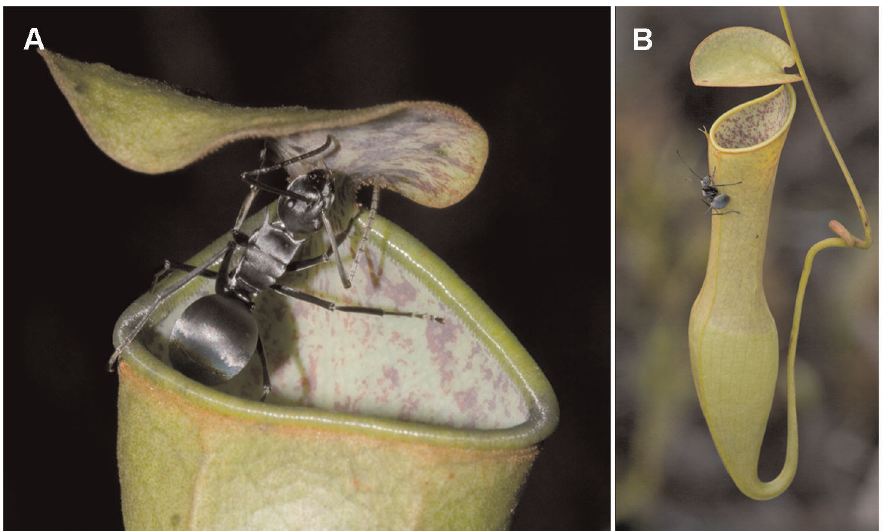
Figure 1. Morphology of N.gracilis pitchers. (A) N. gracilis pitcher with visiting Polyrhachis pruinosa ant, showing the epicuticular wax crystal surfaces on the inner pitcher wall and on the underside of the pitcher lid. (B) The horizontal orientation directly above the pitcher opening puts the lower lid surface in an ideal position for prey capture.